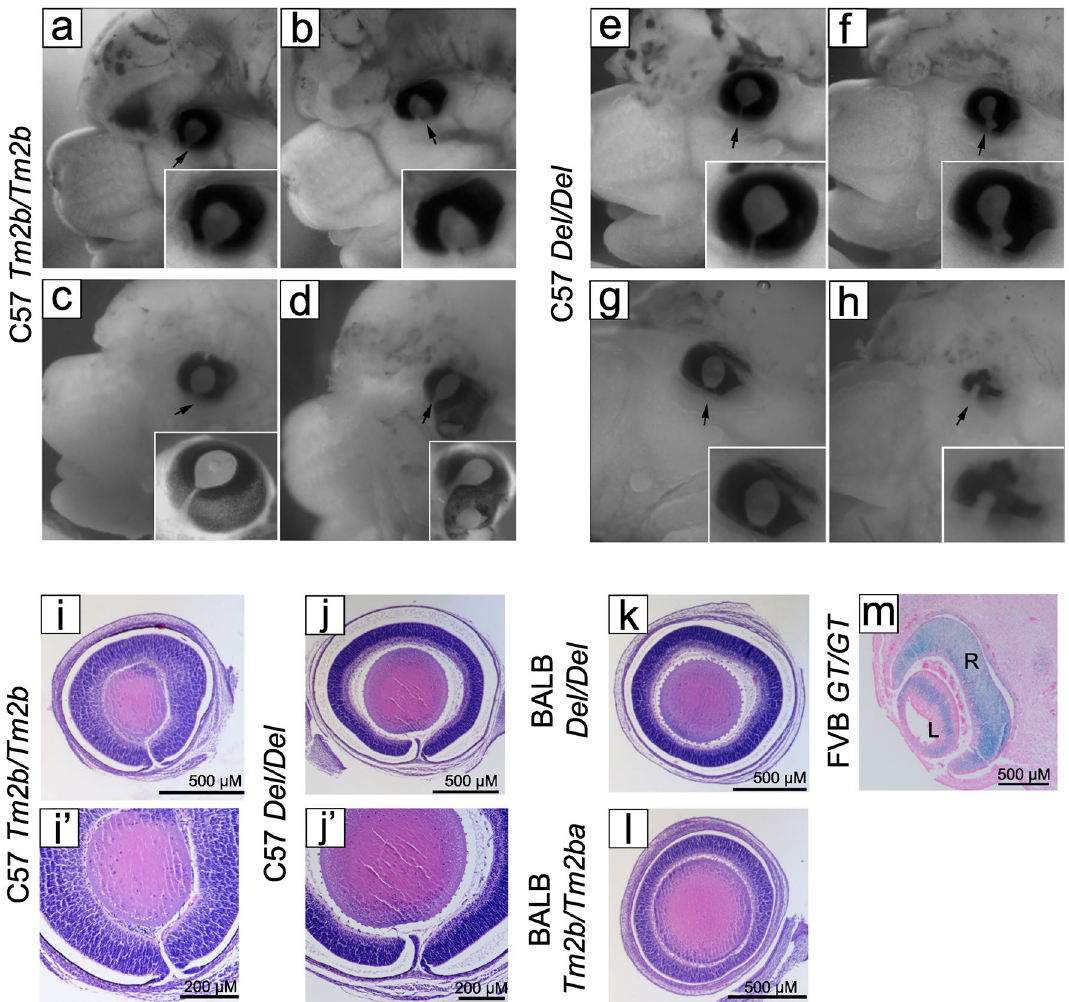
Figure 2. Loss of CECR2 results in coloboma and other eye defects. Examples of colobomas in Cecr2 Tm2b/Tm2b ( a – d ) and Cecr2 Del/Del ( e – h ) embryos on a C57Bl/6N background show the variation in the severity of the defects. Each image has an inset at higher magnification. In ( c ) and ( d ) insets the eye was photographed after removal. The additional defect of microphthalmia is seen in ( h ). For the 2 mutations on a BALB/cCrlAlt background, which have unpigmented eyes, identification of the presence of coloboma was determined partially or completely by histology. Eyes were serially sectioned in the frontal plane and H&E stained. Colobomas were present on a C57Bl/6N background ( i , j , with i’ and j’ at higher magnification) but not on a BALB/cCrlAlt background ( k , l ). X-gal staining of an eye from an FVB/NJ Cecr2 GT/GT embryo at E12.5 suggested that Cecr2 is expressed in the forming retina and lens around the time of optic fissure closure. L = lens, R = forming retina. All embryos pictured also had